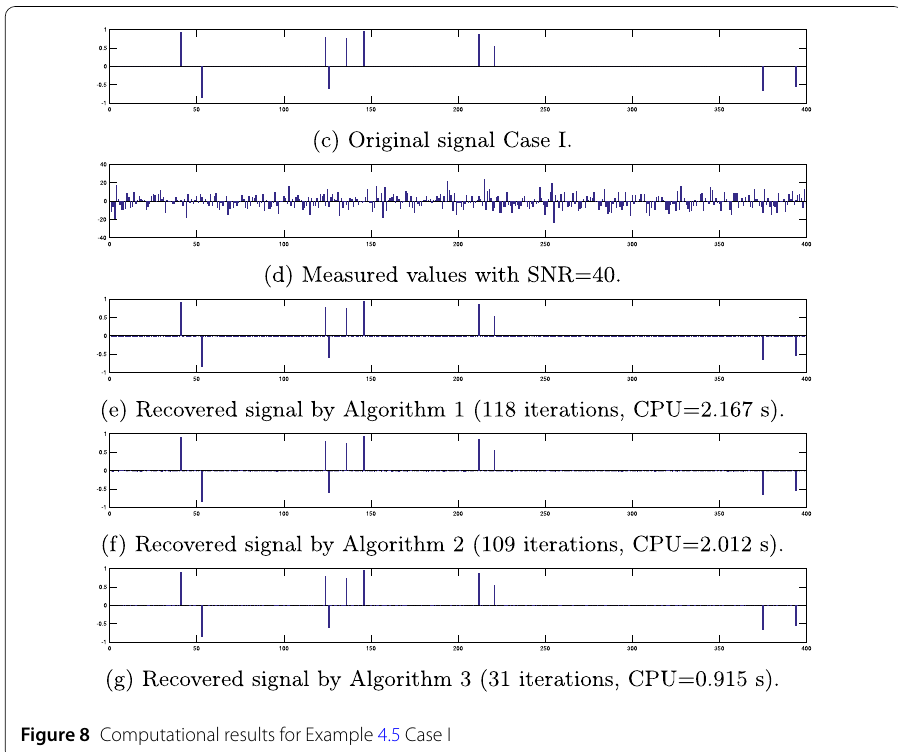
Figure 8 Computational results for Example 4.5 Case I